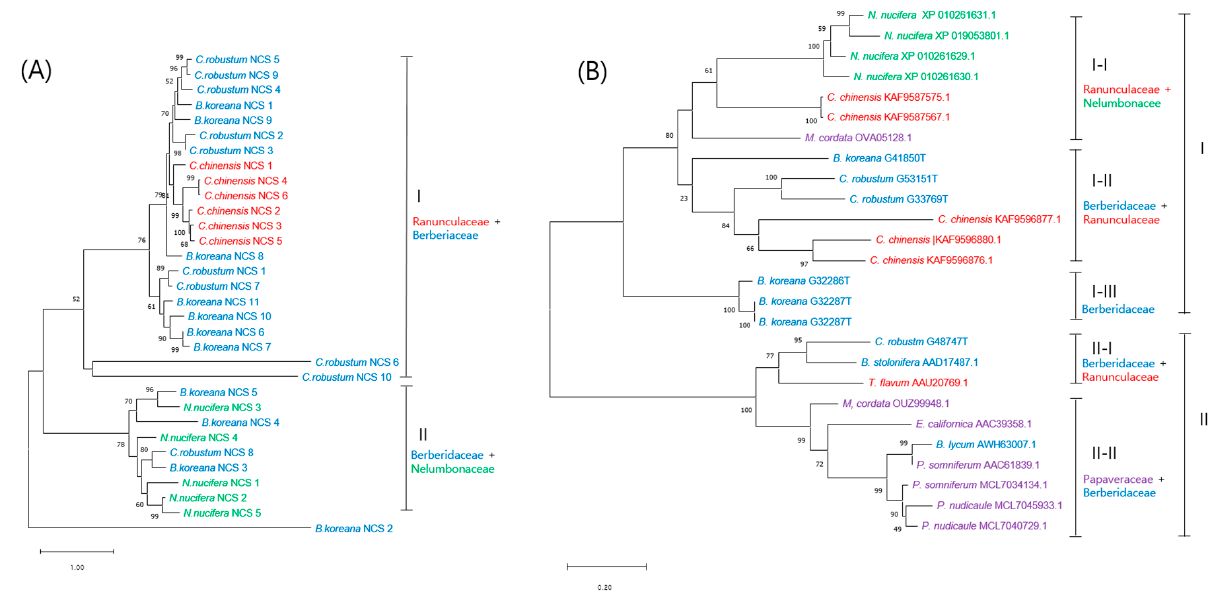
Figure 6. Phylogenetic trees of: (S)-norcoclaurine synthase (NCS) in ( A ); and berberine bridge enzyme (BBE) in ( B ). Species— B. lyceum : Berberis lyceum ; B. koreana : Berberis koreana ; C. chinensis : Coptis chinensis ; C. robustum : Caulophyllum robustum ; E. californica : Eschscholzia californica ; M. cordata : Macleaya cordata ; N. nucifera : Nelumbo nucifera ; T. flavum : Thalictrum flavum ; P. somniferum: Papaver somniferum ; P. nudicaule : Papaver nudicaule . The scale bar represents the phylogenetic distance derived